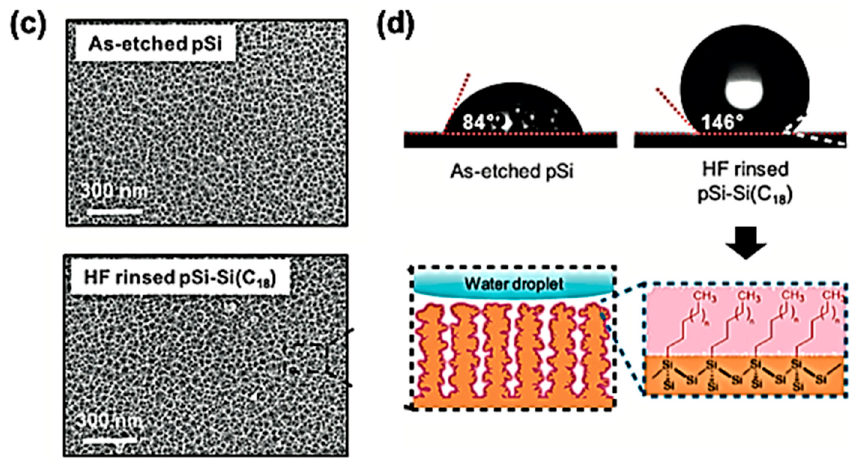
Figure 6. Characterization of a thermally induced dehydrocoupling reaction product of pSi with octadecysilane (H 3 Si-C 18 ). ( a ) Attenuated total reflectance Fourier-transform infrared (ATR-FTIR) spectra of the reagent (H 3 Si-C 18 ) and products (pSi-Si-C 18 ). ( b ) Raman spectra obtained before (As-etched pSi) and after reaction (HF rinsed pSi-Si-C 18 ). ( c ) Scanning electron microscope (SEM) images of pSi before (As-etched pSi) and after reaction (HF rinsed pSi-Si-C 18 ) (plan view). ( d ) Water contact angle image and illustration of the surface after reaction. Reproduced with permission from [58].